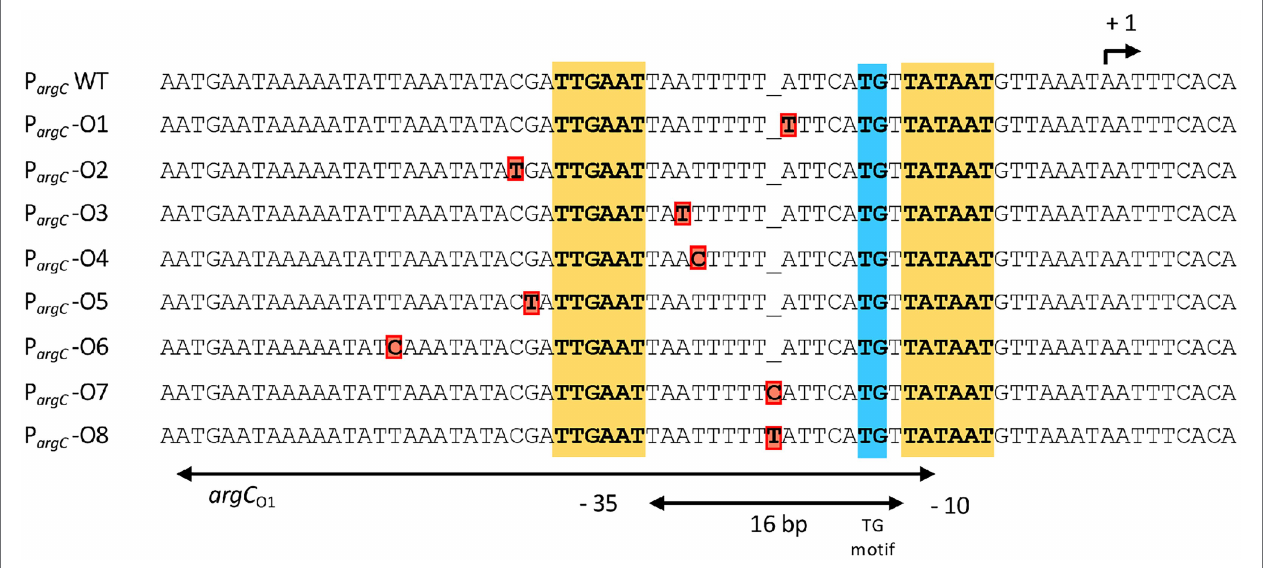
FIGURE 2 | DNA sequence of the argC promoter region and that of the overlapping main operator for the AhrC regulatory protein. AhrC operator mutations derived from the salt-stress resistance suppressor screen are indicated in red. The − 35 and of the extended − 10 regions (with a TG motif) of the argC promoter are highlighted. The argC promoter possesses a sub-optimal spacing of 16 bp in comparison with typical SigA-type promoters of B. subtilis (Helmann, 1995). The transcriptional start site for the argCJBD-carAB-argF operon is indicated by a bent arrow. The AhrC operator(s) and its interactions with the AhrC regulatory protein, which is a homohexamer, have been defined through molecular and structural analysis (Garnett et al., 2007a, 2008). Three ArgC operators are present to transcriptionally control argCJBD-carAB-argF expression. One of these is present in the coding region of the argC gene, while the two other operators are positioned such that one of them overlaps the − 10 and − 35 regions of the SigA-type promoter. The other operator is positioned further upstream, with a 11 bp DNA sequence separating them. Binding of AhrC to the operators overlapping with and juxta positioned to the argC promoter leads to the bending of the DNA (Garnett et al., 2008). The entire regulatory region has been termed argC O1 while the ArgC operator present in argC is referred to as argC 02 (Czaplewski et al.,